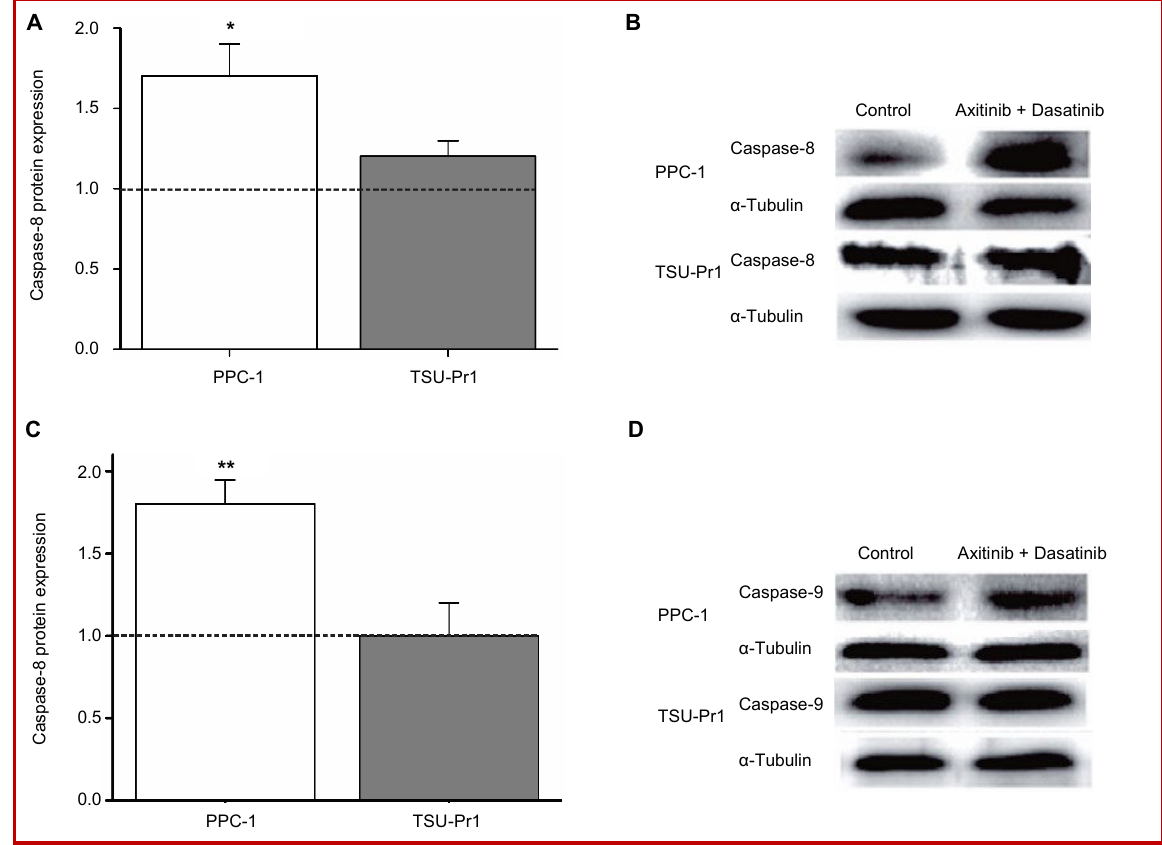
Figure 3: Effect of axitinib and dasatinib (20 mM) on protein levels of caspase-8 (A) and caspase-9 (C) in PPC-1 and TSU-Pr1cells determined by Western Blot analysis. Representative immunoblots for caspase-8 and -9 are shown, respectively, in panels B and D. Results are expressed as fold-variation relatively to control (dashed line) after normalization with